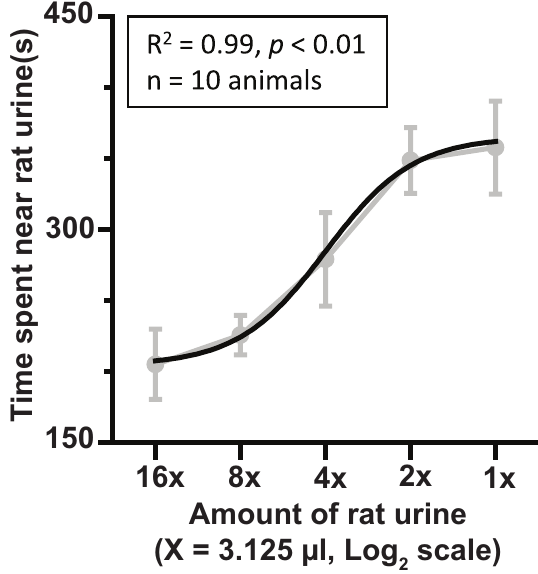
Figure 1. Kairomonal communication in mice is dose-dependent (mean±SEM). Aversion of mice to increasing doses of rat urine was quantified by comparing the time spent in two opposing arms of an arena, with one arm containing incremental doses of rat urine and the other containing buffered saline (trial duration = 600 s, n = 10 mice). The graph depicts average time spent in rat urine arm. The gray line depicts sigmoidal fit. Abscissa depicts dose of rat urine employed (log scale; x arbitrarily set as 3.125 µl of rat 2